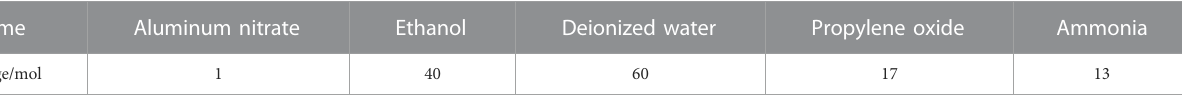
TABLE 1 Experimental formula for the sol-gel synthesis of γ -Al 2 O 3 .